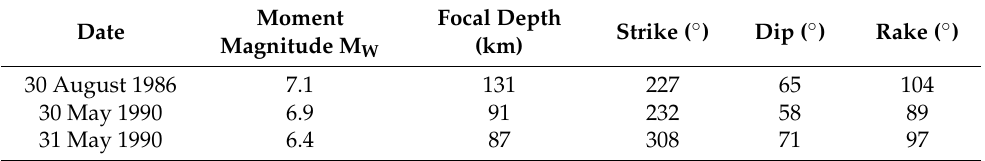
Table 3. Parameters of the focal mechanisms for the three considered earthquakes